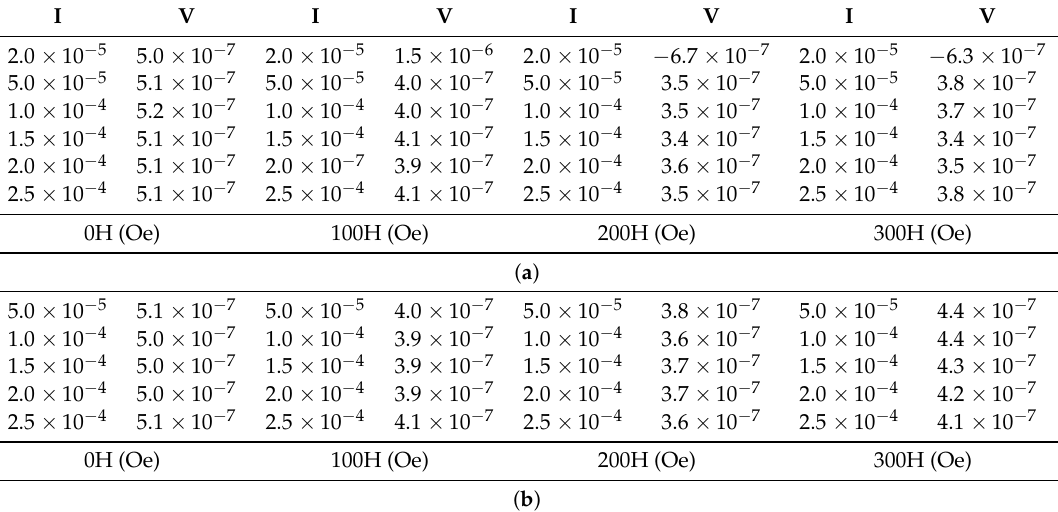
Table 1. Data set used for ANN training: ( a ) T = 8.0 K; ( b ) T = 8.1 K.